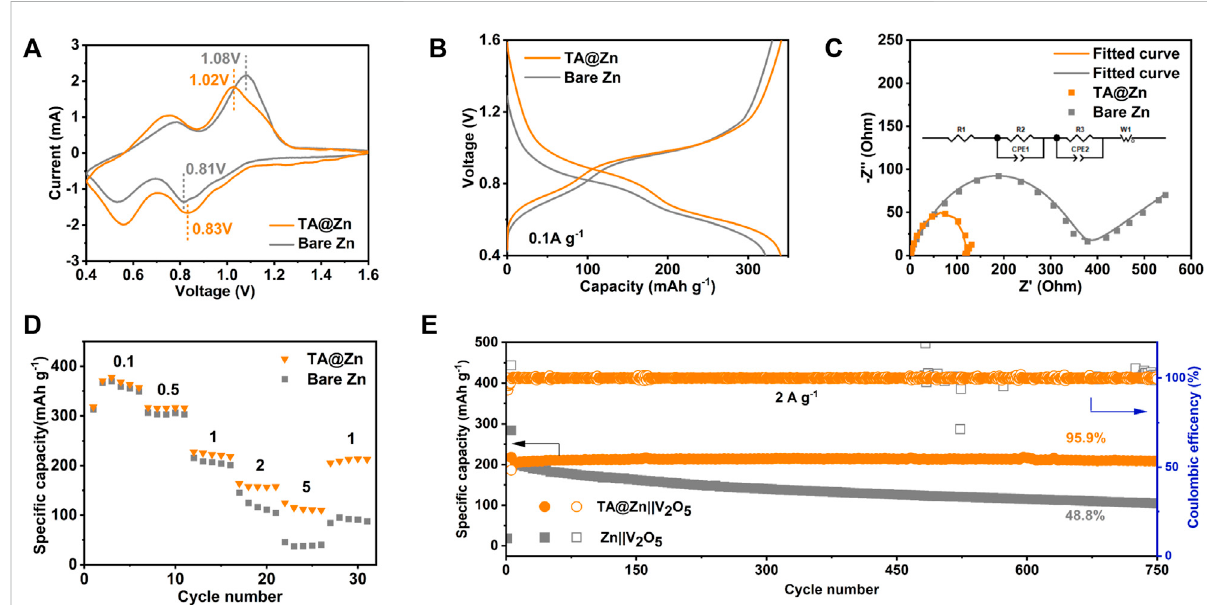
FIGURE 4 Electrochemicalperformanceoffullcells. (A) CVcurvesofZn||V 2 O 5 andTA@Zn||V 2 O 5 fullcells. (B) correspondingchargeanddischargevoltage pro fi les of bare Zn and TA@Zn at 0.1 A g − 1 . (C) EIS of Zn||V 2 O 5 and TA@Zn||V 2 O 5 full cells. (D) rate capabilities of the Zn||V 2 O 5 at different current densities from 0.1 to 5 A g − 1 . (E) long-cycling performance of Zn||V 2 O 5 of bare Zn and TA@Zn at 2 A g − 1